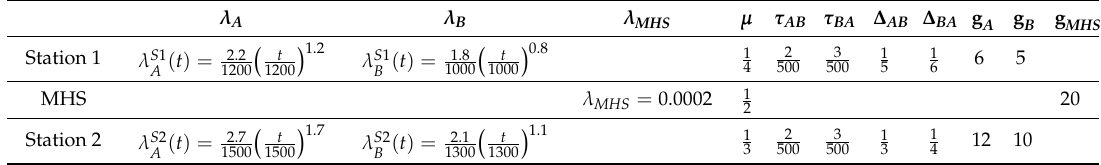
Table 1. The related parameters for equipment at each station.